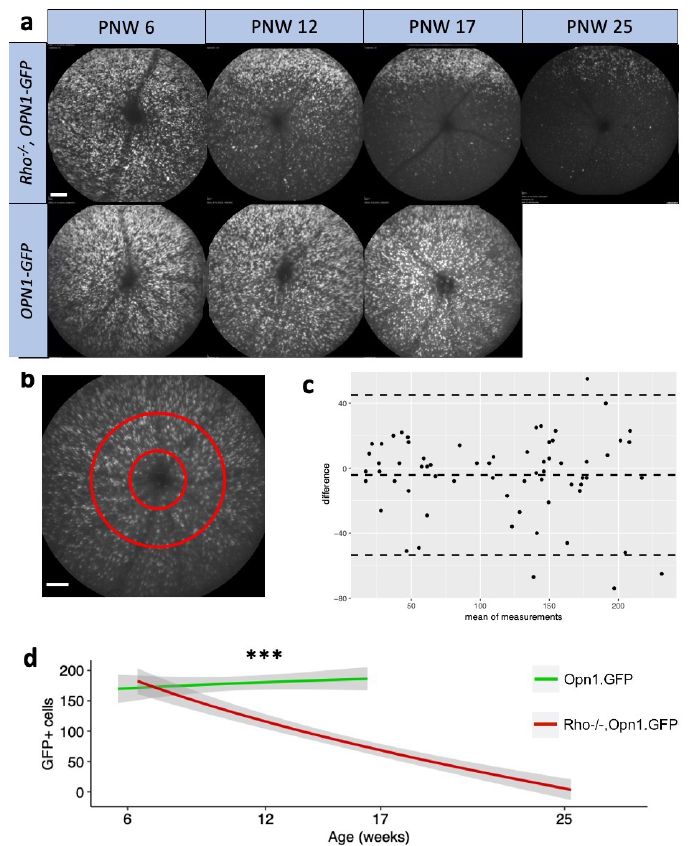
Figure 3. Changes in GFP positive cone photoreceptor cells in Rho −/− OPN1-GFP mice. ( a ) Representative cSLO images demonstrating that Rho −/− OPN1-GFP mice show a decline in GFP positive cone cells in vivo, compared to the steady cone population in the OPN1-GFP mice. Representative images demonstrate the gross pattern of in vivo GFP positive cone cell loss in Rho −/− OPN1-GFP mice. White scale bar = 0.1mm ( b ) To quantify the magnitude of loss of cones, a central annulus was sampled for manual particle counts using the ImageJ counter plugin. White scale bar = 0.1mm ( c ) Bland-Altman plot showing the difference in manual counts between the left and right eyes across the mice shows no obvious systematic error. Some mice had substantial inter-eye differences of GFP-positive cone cells, which is similar to the asymmetric progression of IRDs observed in humans. ( d ) Manual cell counts of fluorescent GFP cells in en face cSLO images of the retina showing loss of cone GFP signal in Rho −/− OPN1-GFP mice and OPN1-GFP mice at cross-sectional timepoints PNW 6 ( n = 9 mice; n = 9 mice respectively), PNW 12 ( n = 5; n = 4), PNW 17 ( n = 12; n = 5), and PNW 25 ( n = 6; n = 0). *** denotes p < 0.001; values are mean cell count ± 95% CI (grey band).